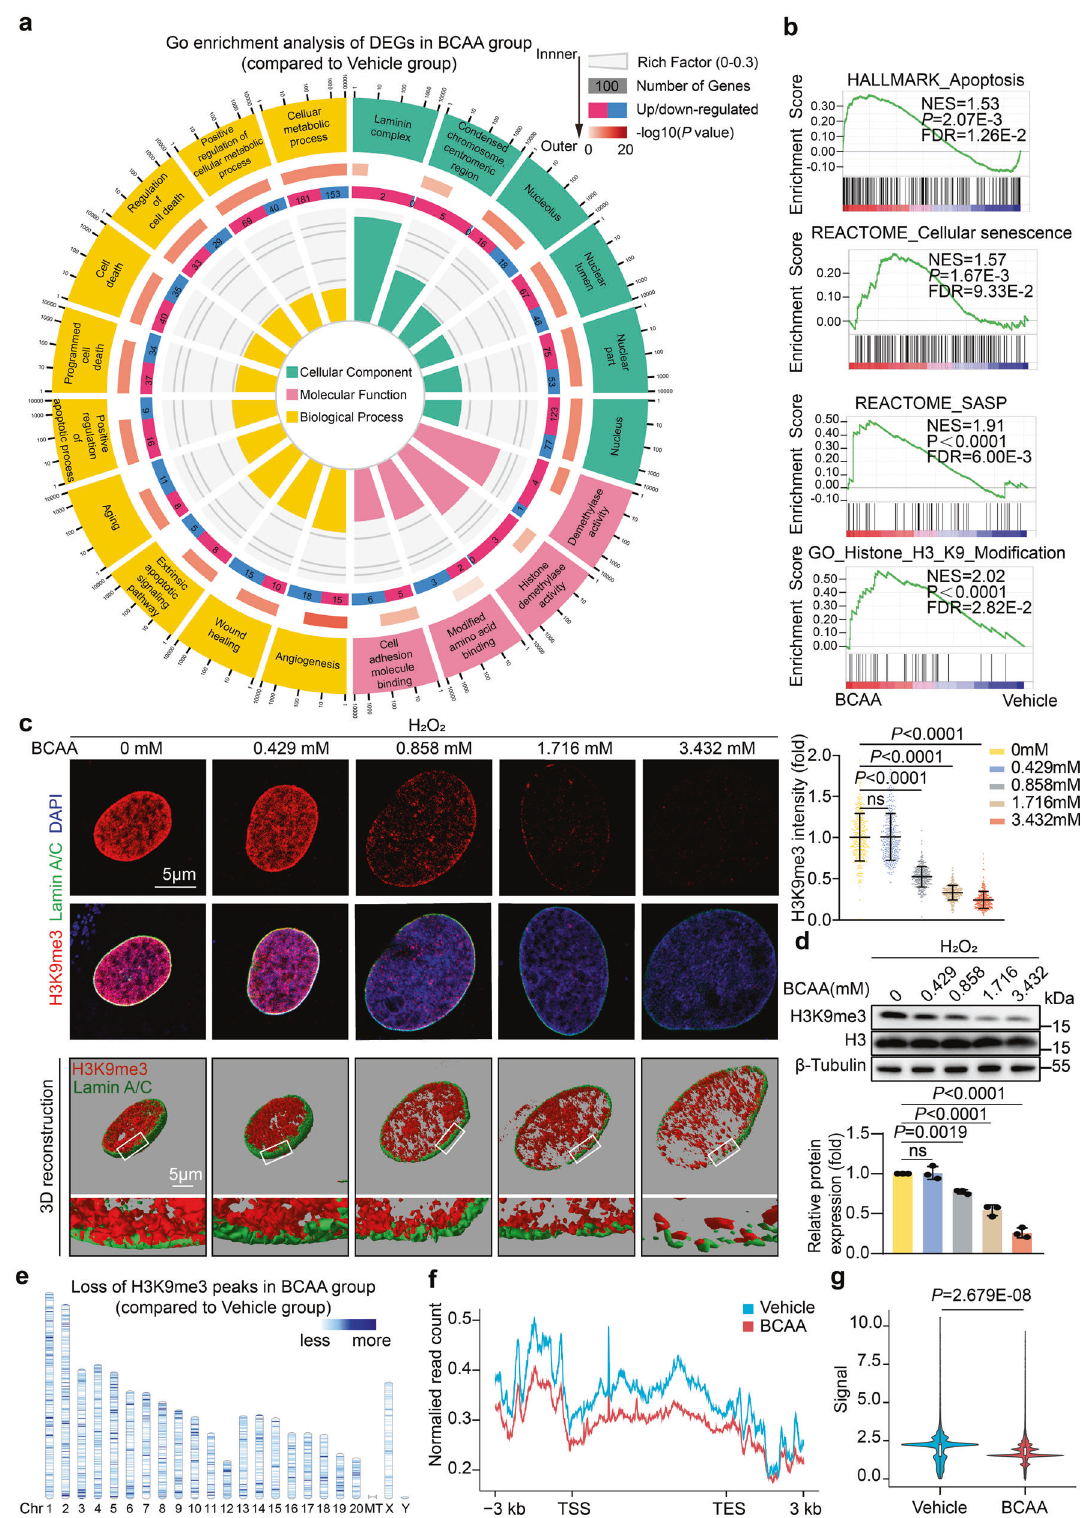
ADSCs implanted into the high BCAA milieu seen in the post- infarction heart. Following MI, ADSCs transfected with scramble RNA (ADSC-Con) or KDM4E siRNA (ADSC- Kdm4e KD) were delivered intramyocardially into WT or PP2Cm KO hearts (Fig. 4e). The ADSCs were labeled by the cell tracker CM-DiI. Signal Transduction and Targeted Therapy (2022)